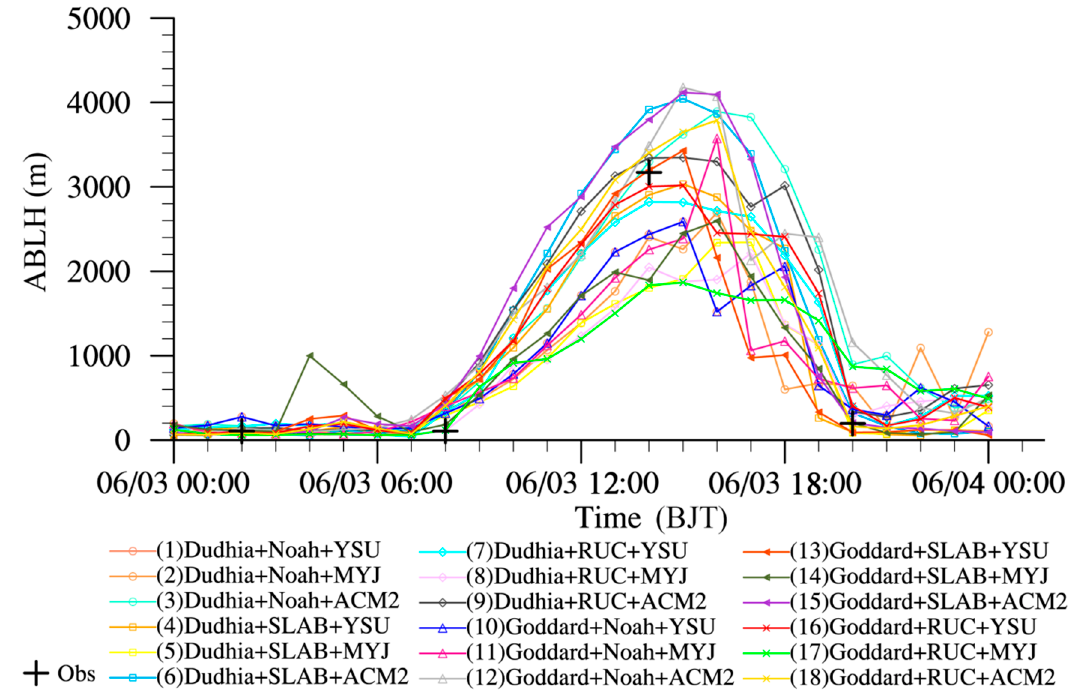
Figure 12. Numerical simulation of Lanzhou using di ff erent combinations of parameterization schemes and calculation of boundary layer heights with ERA-Interim model level data from 16:00 on 2 June 2016, to 16:00 on 3 June 2016.